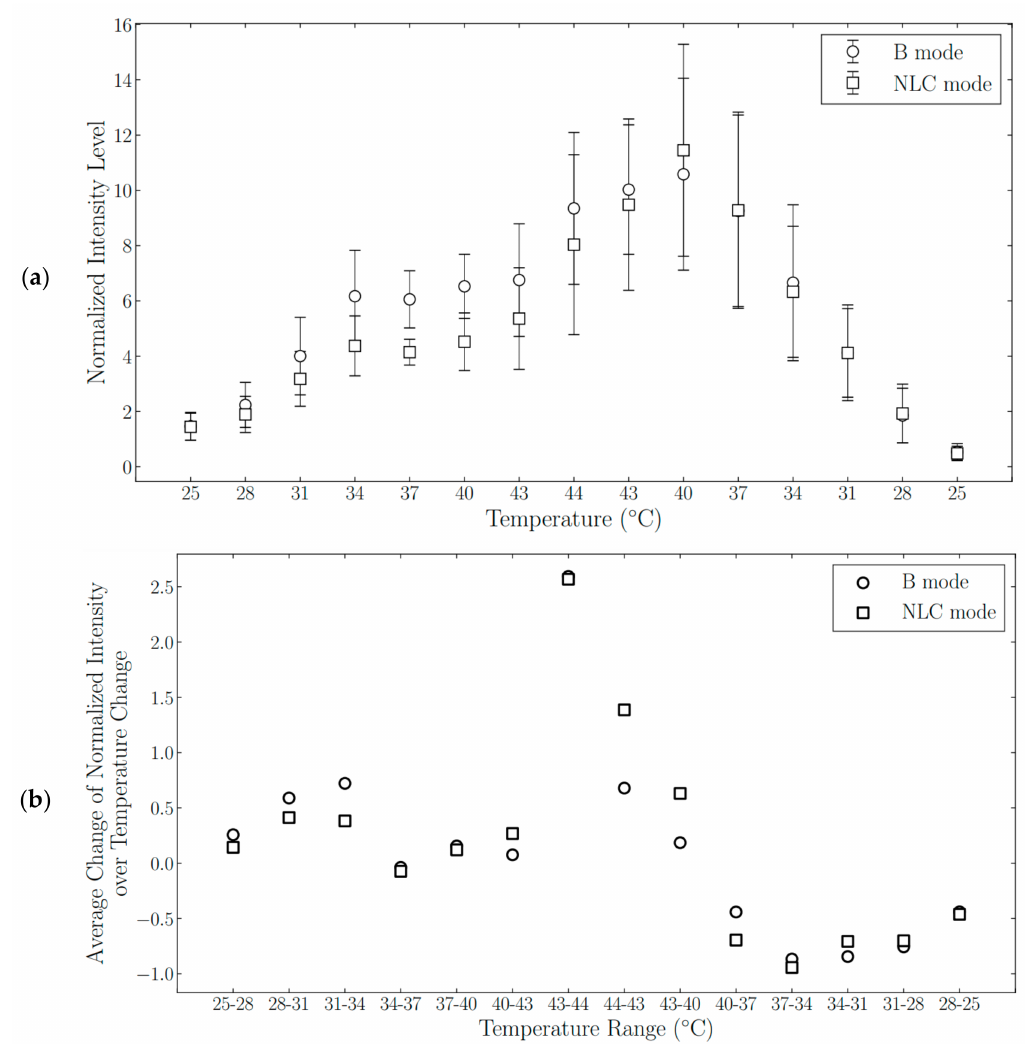
Figure 5. Analysis of thermally responsive nanodroplet behavior. ( a ) Nanodroplet signal intensity as a function of tempera- ture in the B-mode and the NLC mode ( n = 5). The data were normalized by the mean signal intensity at 25 ◦ C. ( b ) The mean rate of change of nanodroplet echogenicity with respect to temperature plotted over selected temperature